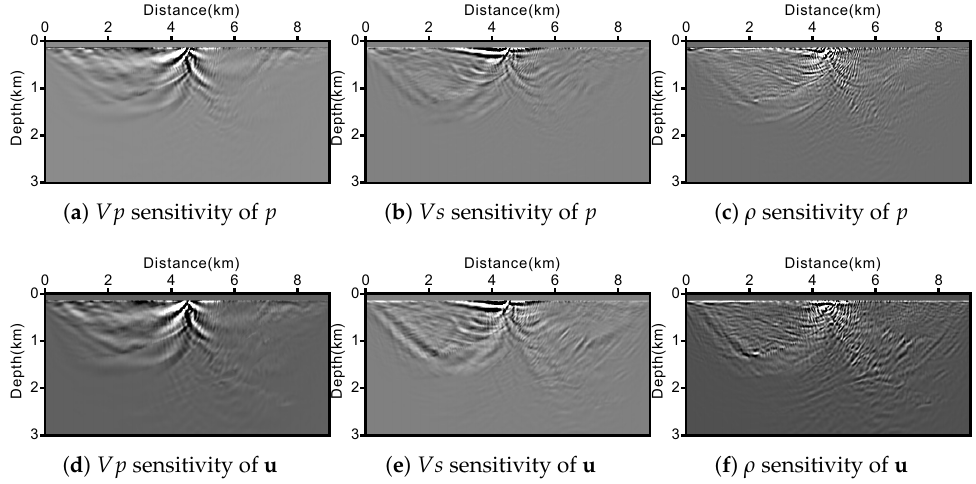
Figure 2. Sensitivity kernels of pressure (top) and displacement (bottom) components with respect to ( a , d ) Vp , ( b , e ) Vs , and ( c , f ) ρ